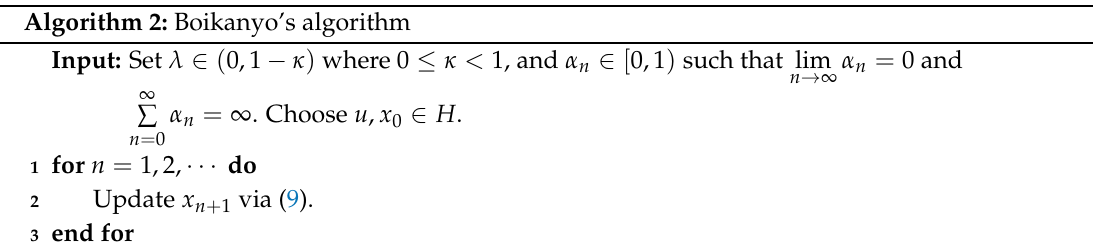
Algorithm 2: Boikanyo’s